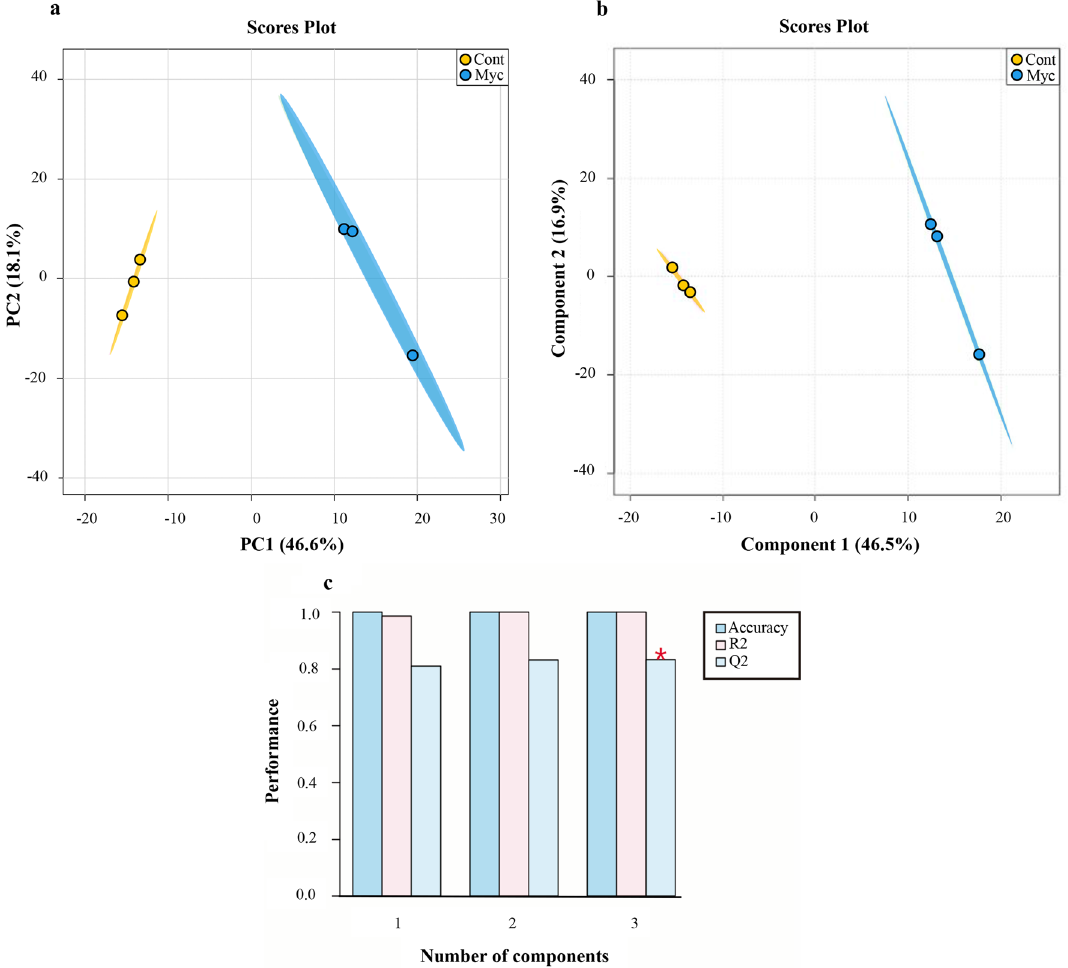
Figure 4. Overview of the metabolic reprograming analysed by FT-ICR in mycorrhizal and non-inoculated roots interpreted using PCA and PLS-DA. ( a ) PCA scores plot of mycorrhizal (Myc) and non-inoculated (Cont) cork oak roots. Each point represents a biological replicate ( b ) PLS-DA scores plot of mycorrhizal (Myc) and non-inoculated (Cont) cork oak roots. Each point represents a biological replicate. ( c ) Cross-validation scores plot of the PLS-DA for the classification into mycorrhizal and non-inoculated groups using the FT-ICR data as a function of the number of PLS components. The number of components that maximizes Q2 is indicated with a star. Charts were produced with the free available on-line software MetaboAnalyst v4.0 (https:// www. metab oanal yst.